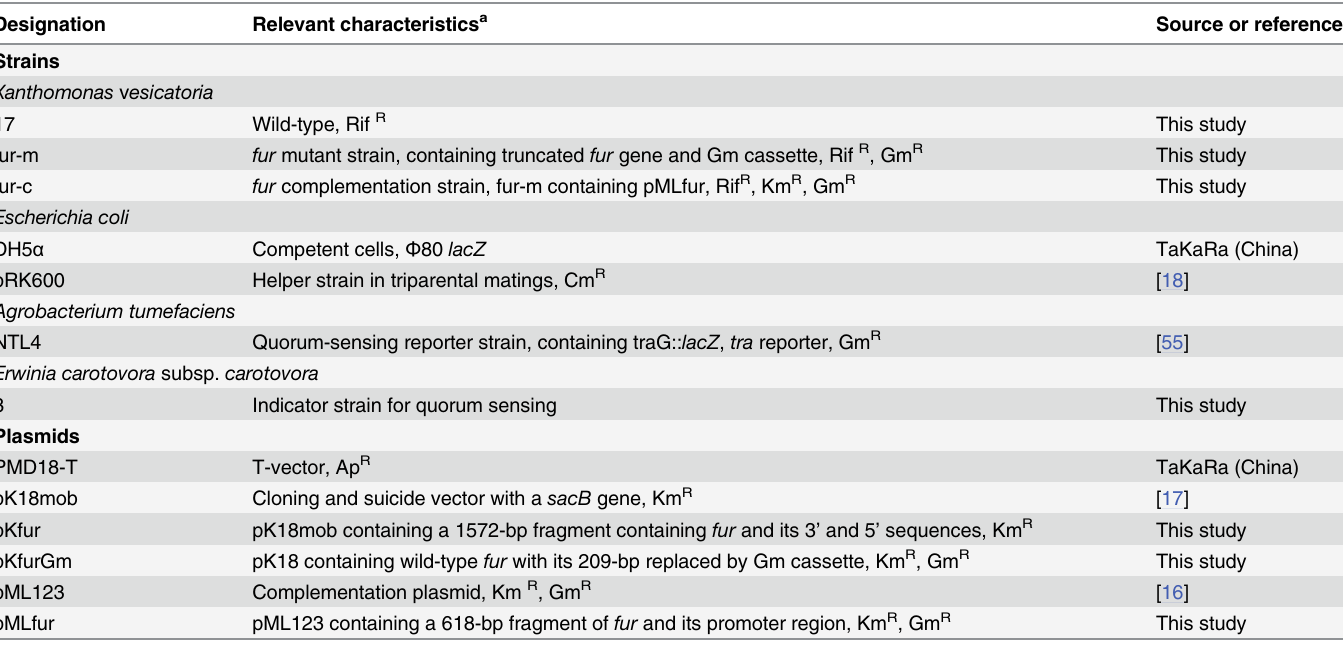
Table 1. Bacterial strains and plasmids used in this study.